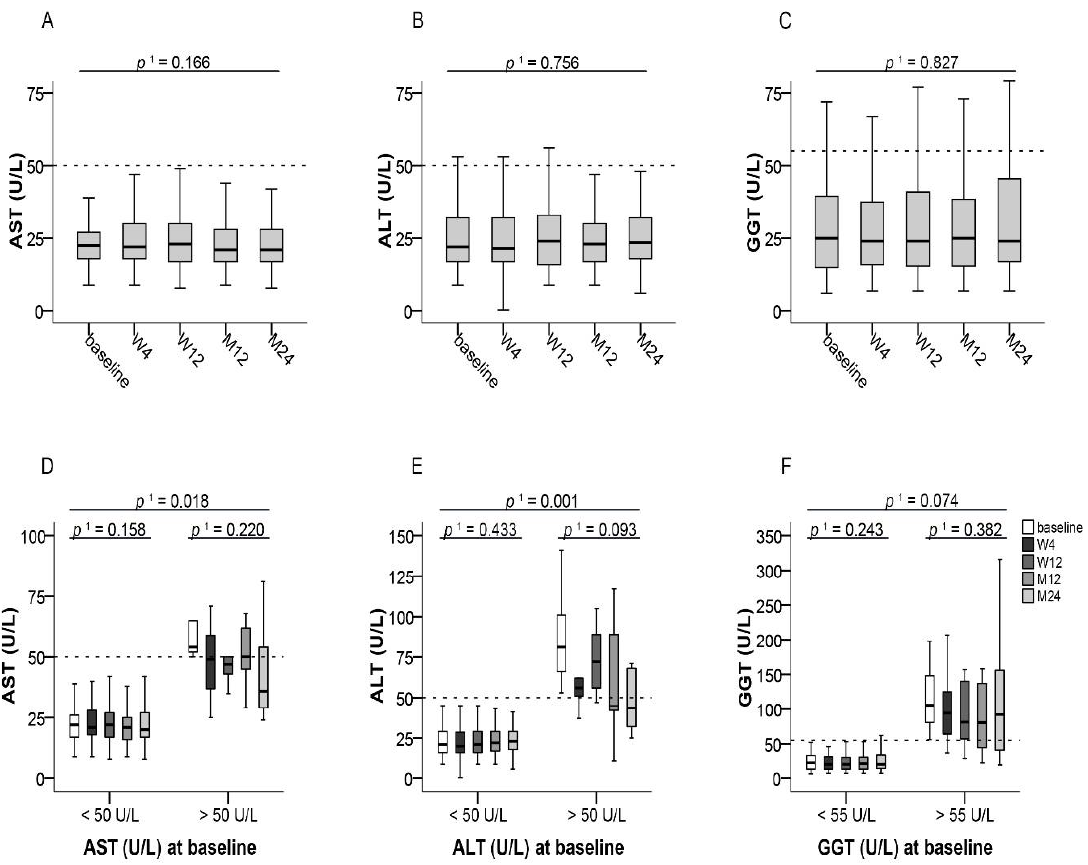
Figure 2. Liver transaminases after switching to LCPT. ( A – C ): Boxplots show median values with 95% CI for AST, ALT, and GGT at the baseline visit as well as at weeks 4 and 12 and at months 12 and 24; ( D – F ): Boxplots show median values with 95% CI for AST, ALT, and GGT according to normal or increased transaminase values at baseline. 1 with Greenhouse–Geisser correction; ALT: alanine amino transferase, AST: aspartate amino transferase, GGT: gamma-glutamyl transferase, LCPT: once-daily MeltDose ® prolonged-release tacrolimus, M: month, W: week.